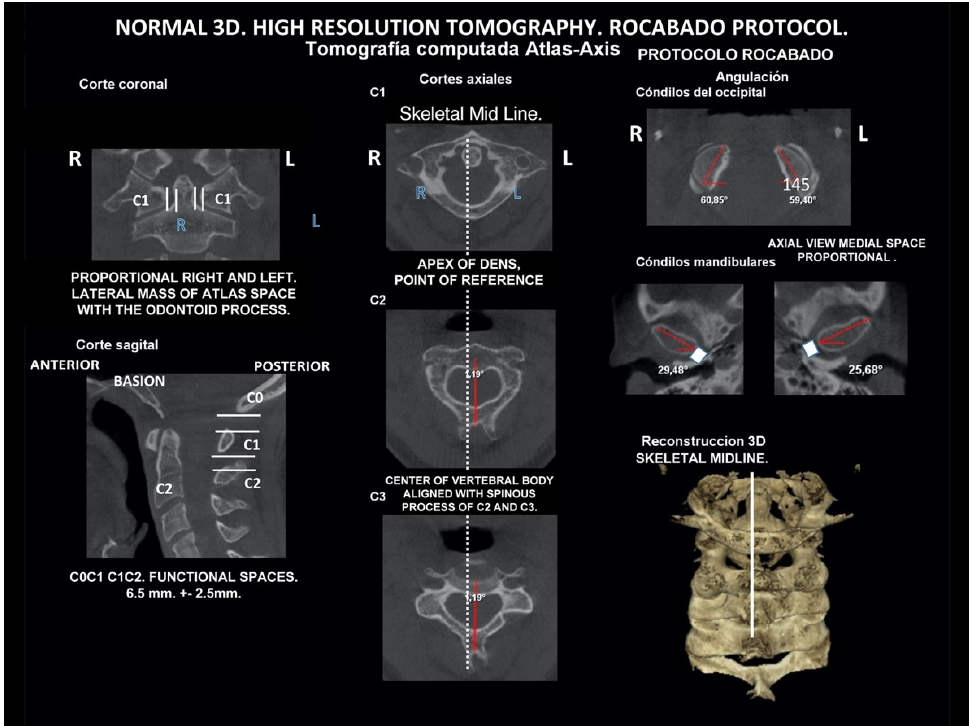
Figure 5. Rocabado diagnostic protocol for cervical spine.